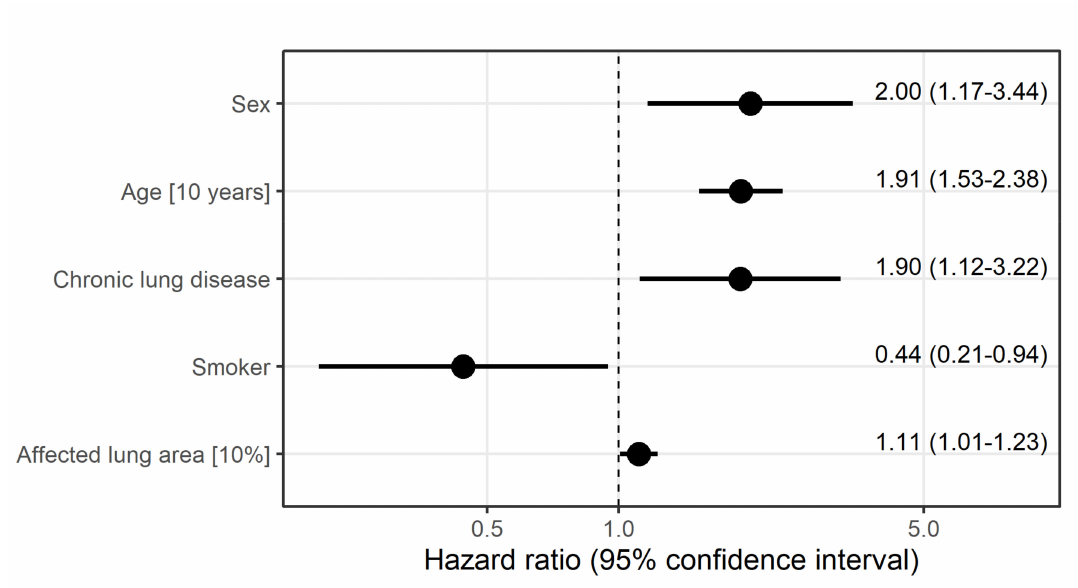
Figure 5. Hazard ratio estimates along with 95% confidence intervals derived from Cox regression model to identify factors associated with the instantaneous risk of death. All variables displayed were included in the